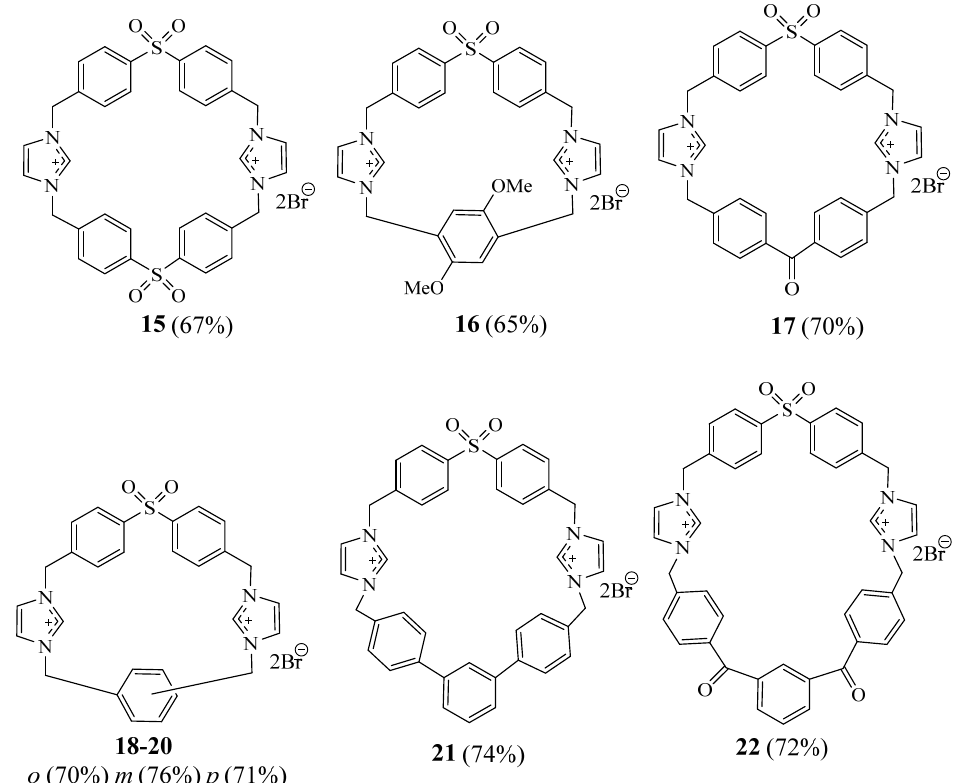
Figure 5. Structures of macrocycles 15 − 22. (Reprinted with permission from ref. [20]. Copyright 2011 Elsevier).